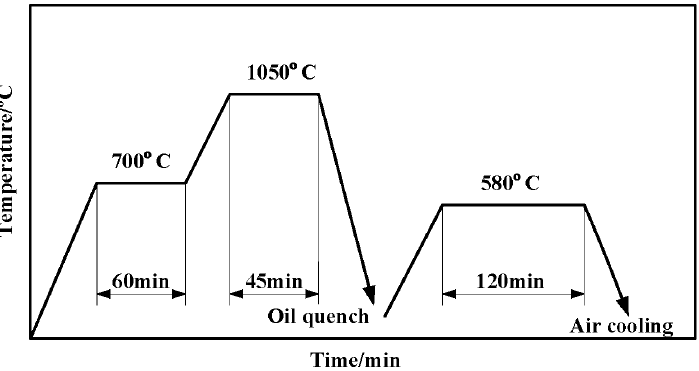
Figure 1. Quenching-tempering heat treatment process curve.